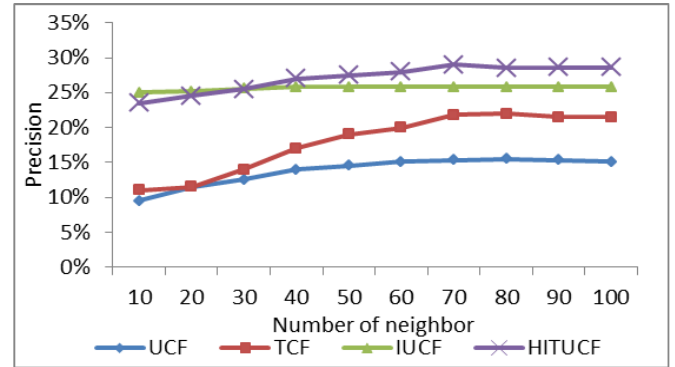
Figure 17. Relation between precision and number of neighbors on 1M Movielens dataset.